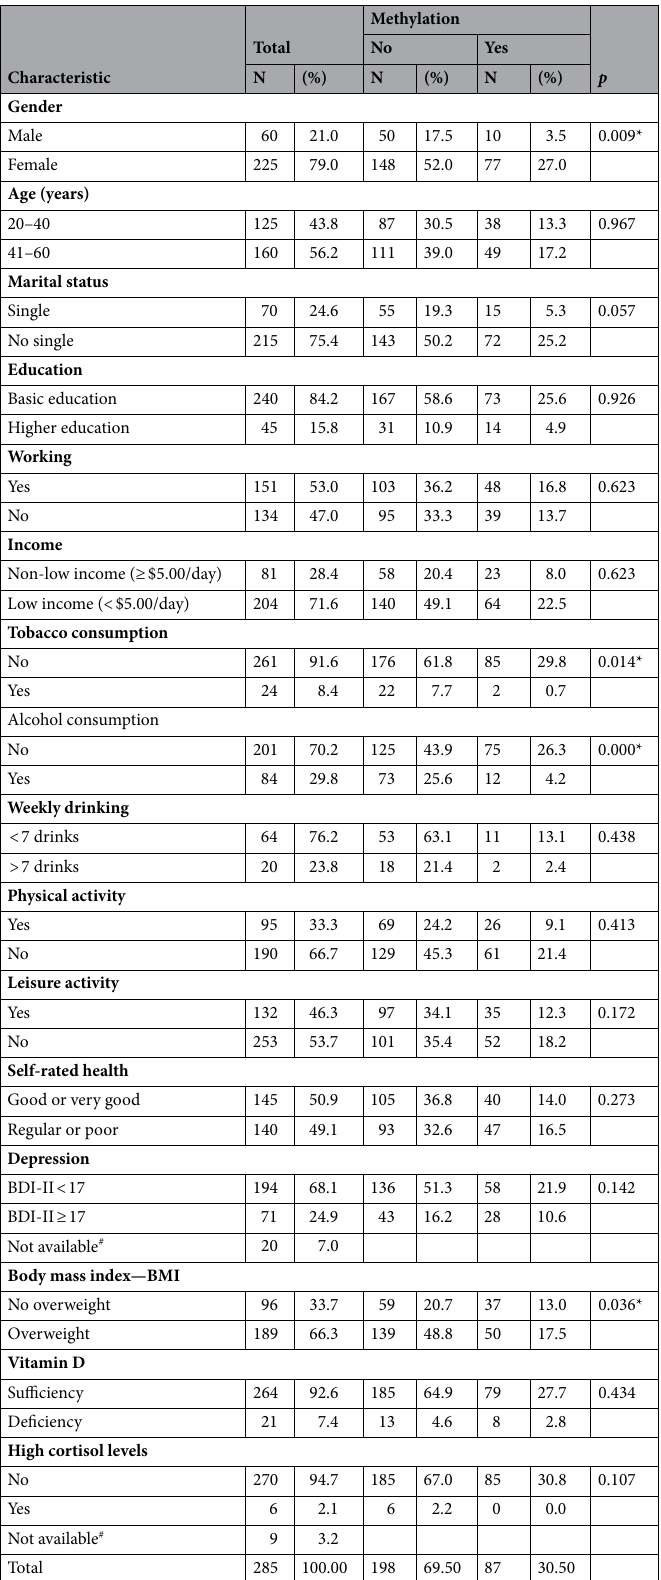
Table 2. Sample characteristics according to methylation of 1F region NR3C1 gene. BDI-II Beck Depression Inventory-II, BFIS Brazilian Food Insecurity Scale, FNS Food and Nutrition Security, FNiS Food and Nutrition Insecurity, BMI Body Mass Index. # Not available (not considered in the statistical calculations). Categorical variables presented in relative (%) and absolute (n) frequencies. Quantitative variables presented in medians and interquartile ranges (IR), according to normality (Kolmogorov–Smirnov test); * p value: Mann–Whitney U or chi-square, at 5% significance (p <